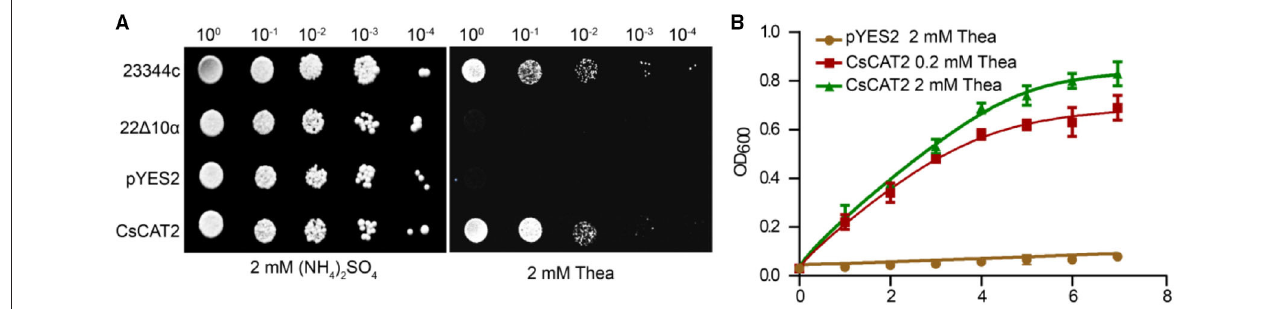
FIGURE 3 | CsCAT2-mediated theanine uptake into yeast cells. (A) Dot assays showed the growth phenotype of yeast lines 23344c (wild-type line), mutants 22 1 10 α , 22 1 10 α /pYES2 (pYES2), and 22 1 10 α /pYES2- CsCAT2 (CsCAT2), on medium with 2mM (NH 4 ) 2 SO 4 or 2mM theanine (Thea) as nitrogen source. (B) The growth curve of yeast in liquid medium at different theanine concentrations as nitrogen source. The OD 600 value was identified as a parameter for measuring yeast growth. 23344c and the empty vector pYES2 were the positive and negative controls, respectively. The result was expressed as mean ± SD ( n = 3).